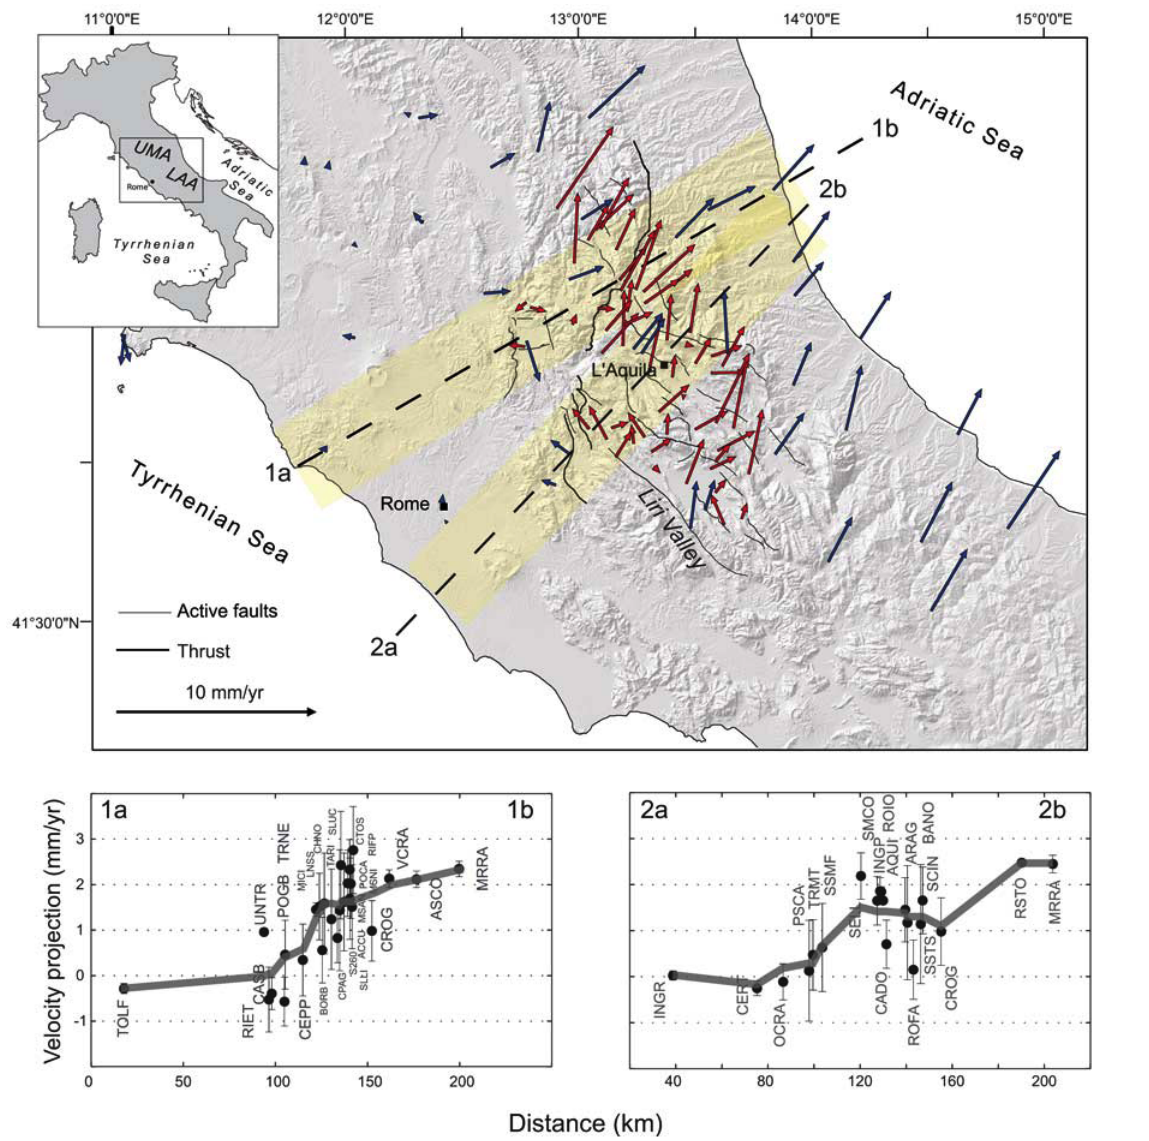
Figure 5. Velocity projections along the transect directions 1a–1b and 2a–2b. The projections involved vertices at distances of 20 km and 15 km in both perpendicular directions along the transect directions for the profiles 1a–1b and 2a–2b, respectively. Inset: Location of the study region within Italy. UMA, Umbria-Marche Apennines; LAA, Lazio-Abruzzo